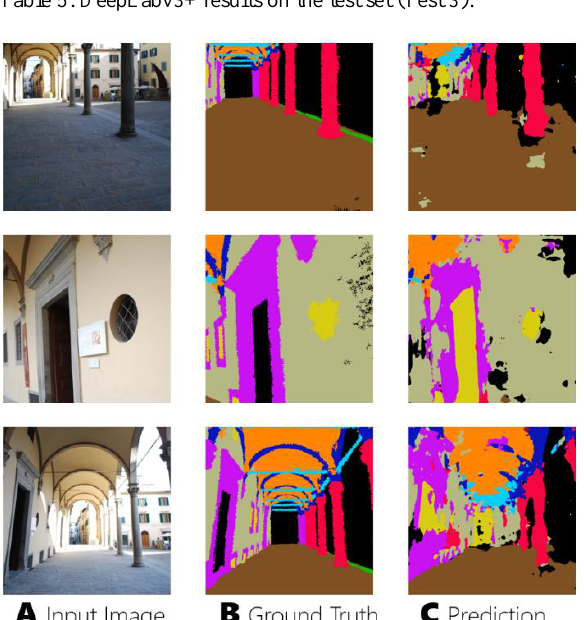
Figure 5: DeepLabv3+ results on the test set (Test 3): A) input image, B) ground-truth, C) prediction.